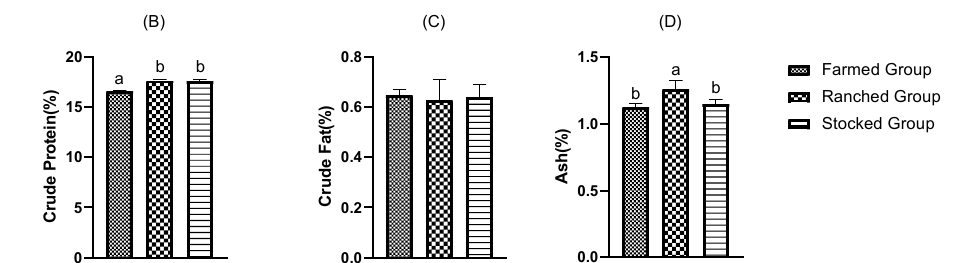
Figure 1. Comparison of muscle proximate composition of three groups (means ± SD, %, fresh weight) ( n = 10). ( A ) Moisture; ( B ) crude protein; ( C ) crude fat; ( D ) ash. Different letters on the error line indicate significant differences ( p < 0.05). The absence of statistical signs denotes no statistically significant differences among treatments ( p > 0.05).